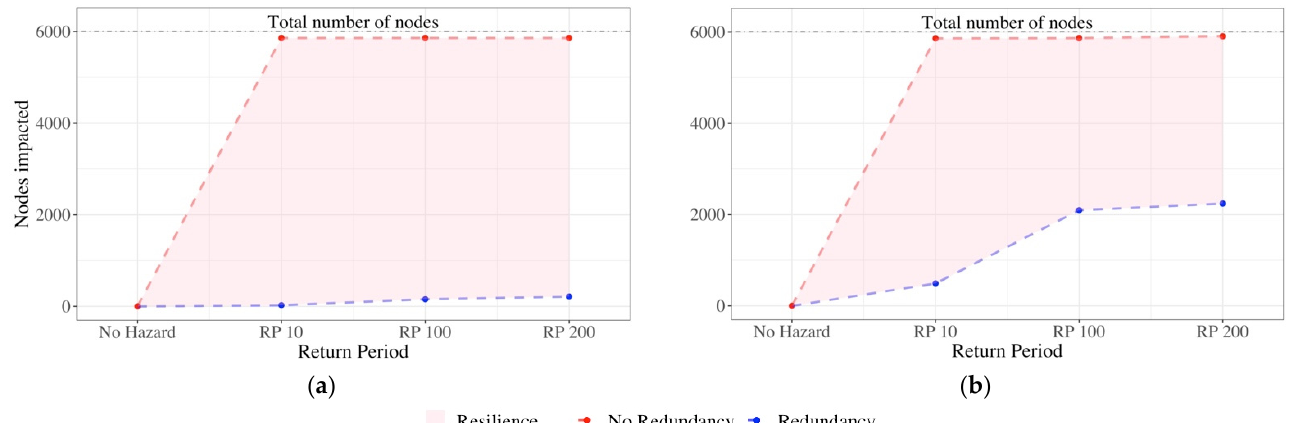
Figure 12. Representation of the resilience as the difference between adaptable and redundant graph respect to the static